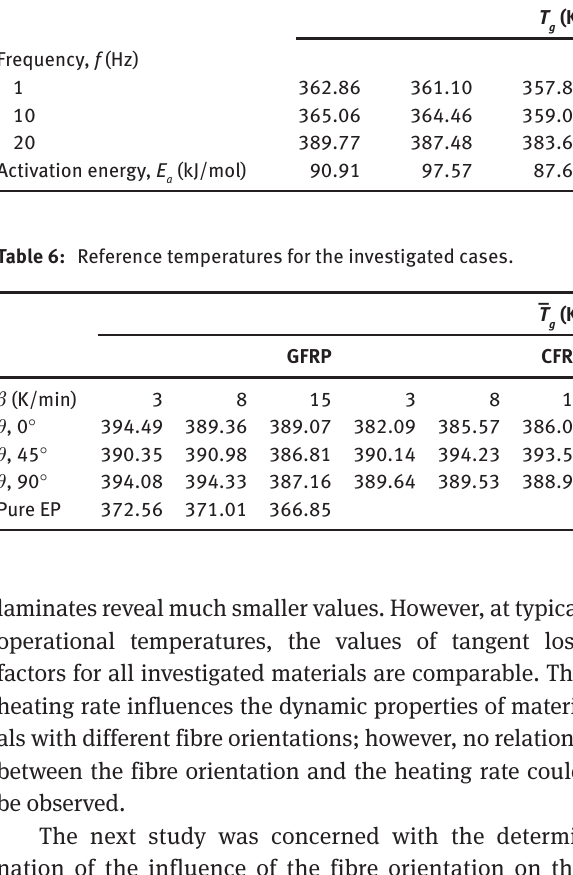
Table 5: Values of T